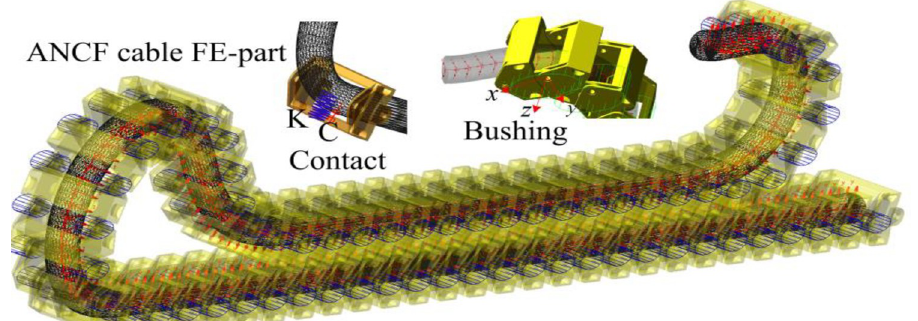
Fig 15. Fe-part model of shearer cable based on ANCF